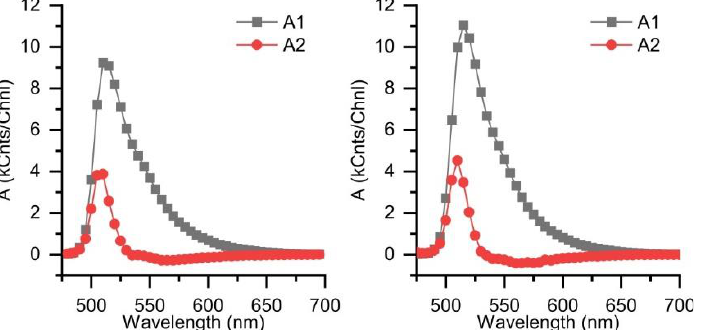
Figure A1. Spectra of amplitudes A 1, A 2 obtained from global fitting of time-resolved fluorescence spectra of 11 in dichloromethane ( left ) and toluene ( right ) λ ex = 440 nm.